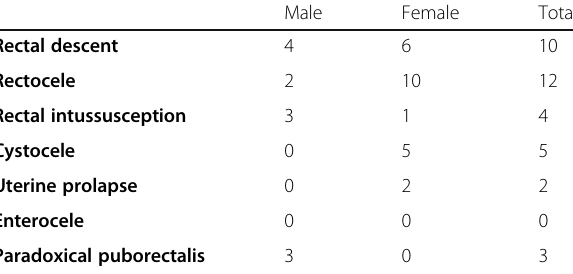
Table 2 Comparison between male and female clinical findings